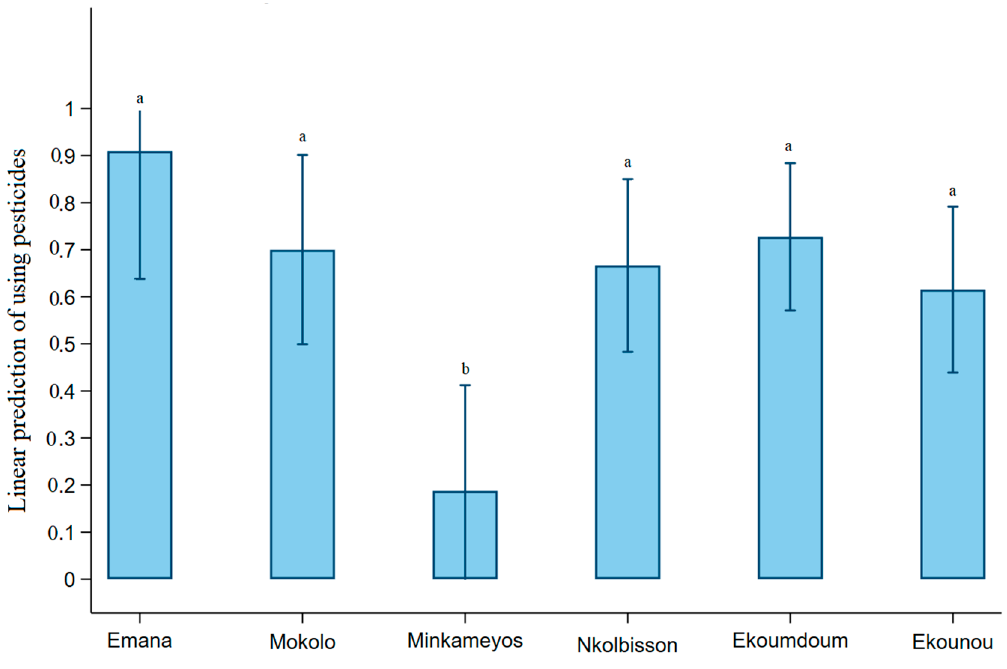
Figure 7. Probability of using pesticides in the studied areas of Yaoundé (same letter indicates no significant differences at p < 0.05 at 95% confidence intervals).